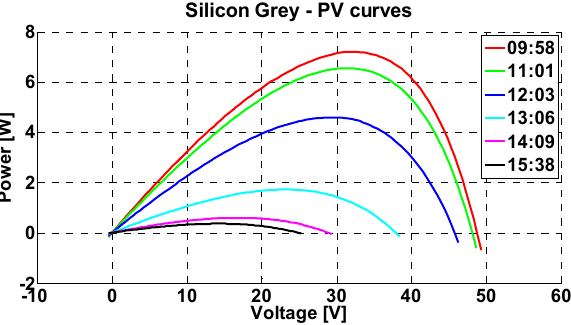
Figure 18. Blue silicon cell current-voltage curves for different irradiance values.